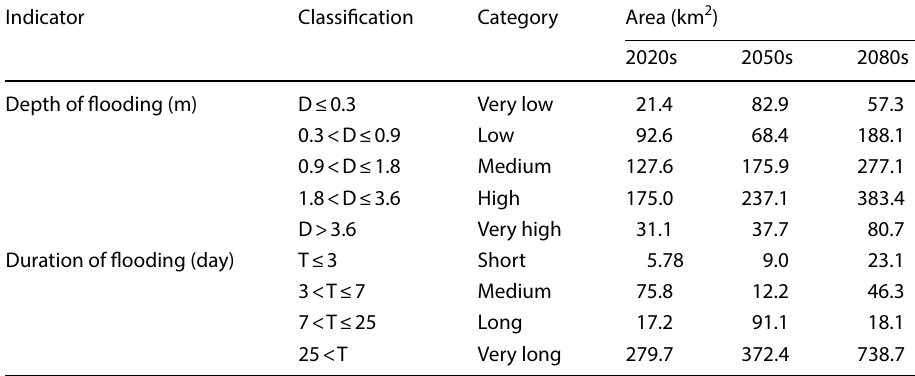
Table 4 Flood-affected area (km 2 ) under each flooding